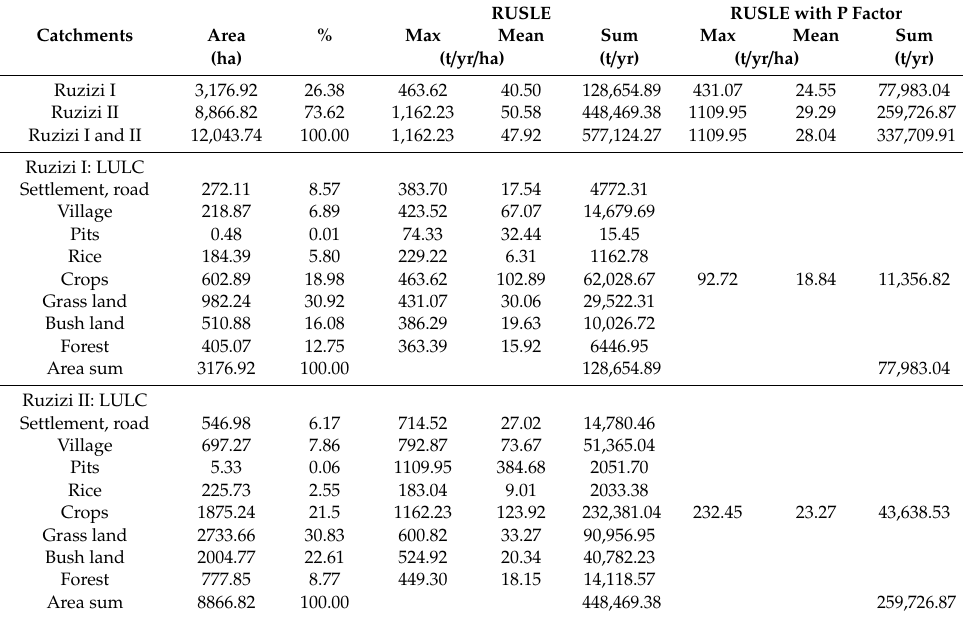
Figure3. Resultsof(R)USLEcalculations( A )withoutand( B )withPfactorvaluesforterracing[15,16,23,49]. Figure 3. Results of (R)USLE calculations ( A ) without and ( B ) with P factor values for terracing [15,16,23,49]. Table 6. (R)USLE results for di ff erent LULC classes and sub-catchments Ruzizi I and II.